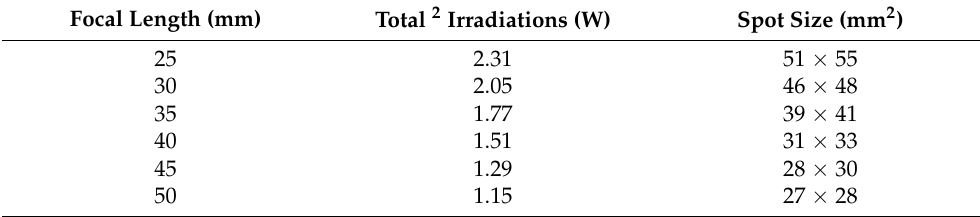
Table 2. Irradiation performances by different focal lengths of collimation lenses.